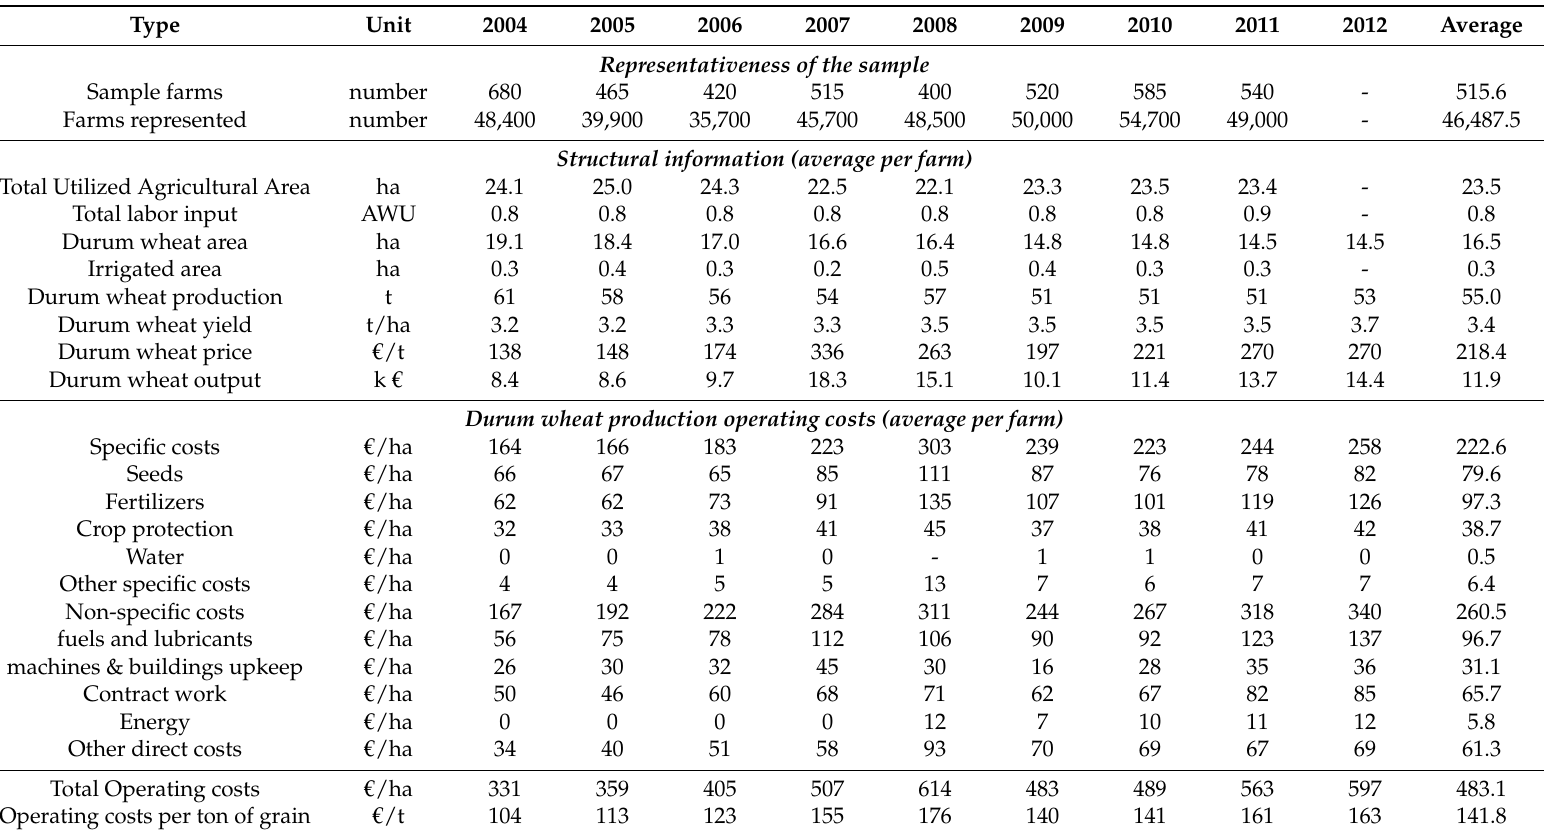
Table 2. Italian farms specializing in durum 249 wheat (The European Commission,